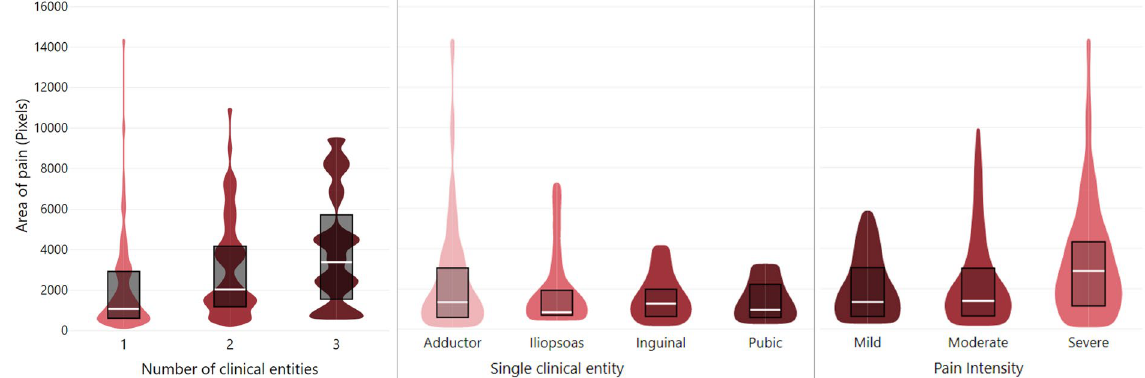
Figure 5. Pain area (expressed in pixels) extracted from digital pain drawings of groin pain, according to ( A ) Number of diagnosed clinical entities: one (N = 88), two (N = 64), and three (N = 15), ( B ) Diagnosed clinical entity in athletes with only one clinical entity: adductor-related (N = 39), iliopsoas-related (N = 18), inguinal- related (N = 24), and pubic-related (N = 7) groin pain, and ( C ) Self-reported intensity of the pain descriptors (mild N = 18, moderate (N = 99), severe (N = 50). White lines signify medians, black lines signify interquartile ranges, and colored area signifies